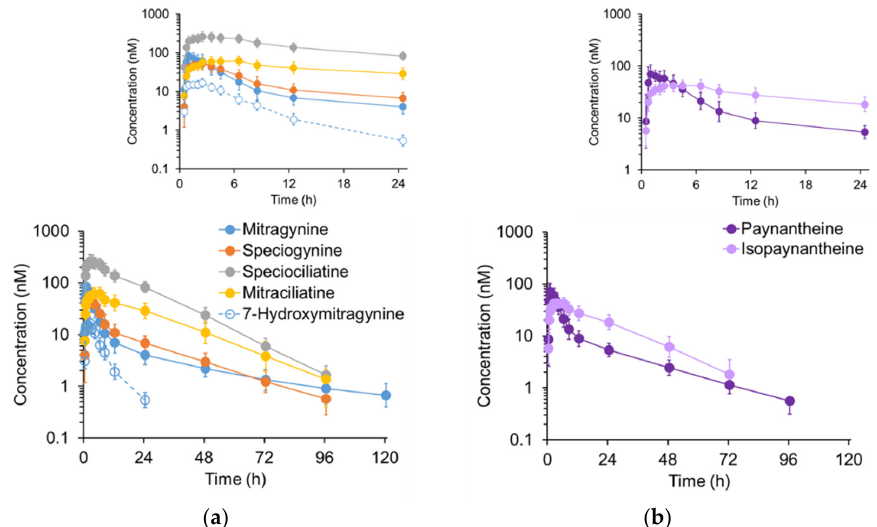
Figure 3. Plasma concentration-time profiles for ( a ) mitragynine, mitragynine diastereomers, and 7-hydroxymitragynine and ( b ) paynantheine and isopaynantheine following oral administration of a well-characterized kratom product as a tea to six participants. Kratom tea was prepared with 2 g of yellow Indonesian Micro Powder (K51) in 240 mL of hot water (80 °C), which was allowed to steep for three minutes. A sugar packet (4 g) was added to improve palatability. The prepared tea was cooled to 50 °C before administration to the participants. Symbols and error bars denote geometric means and 90% confidence intervals, respectively. Insets show the 0–24 h profiles to better visualize alkaloid concentrations during the intensive sampling period after administration of the kratom tea.